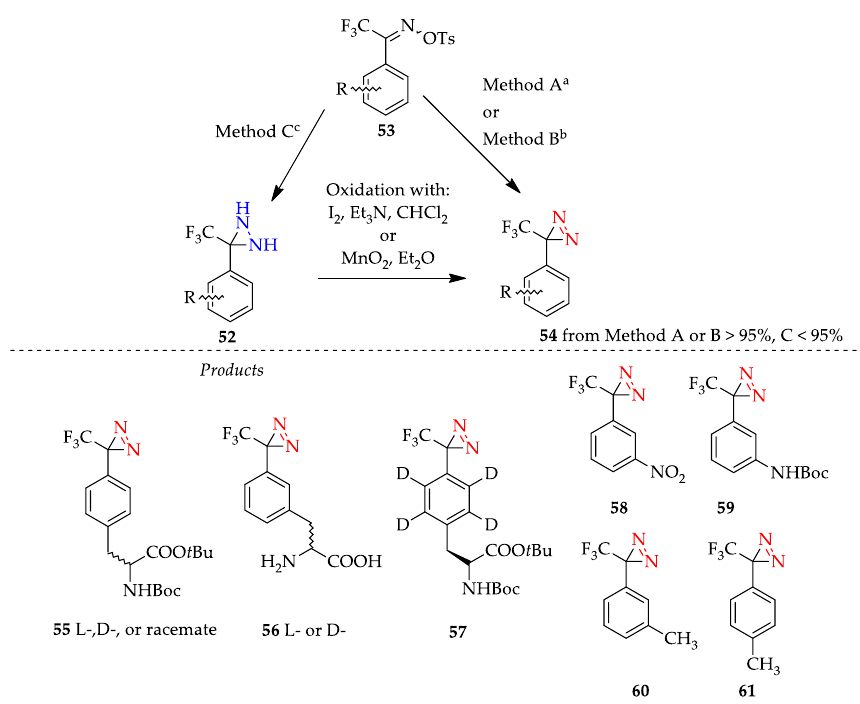
Figure 7. Comparison of conventional methods and the one-pot system for the synthesis of 3-phenyl-3-(trifluoromethyl)-3 H -diazirine 54 (TPD) from tosyl oxime 53 . a Method A: NH 3 (l), 80 °C. b Method B: NH 3 (l), LiNH 2 , rt. c Method C: NH 3 , Et 2 O, rt (Conventional).